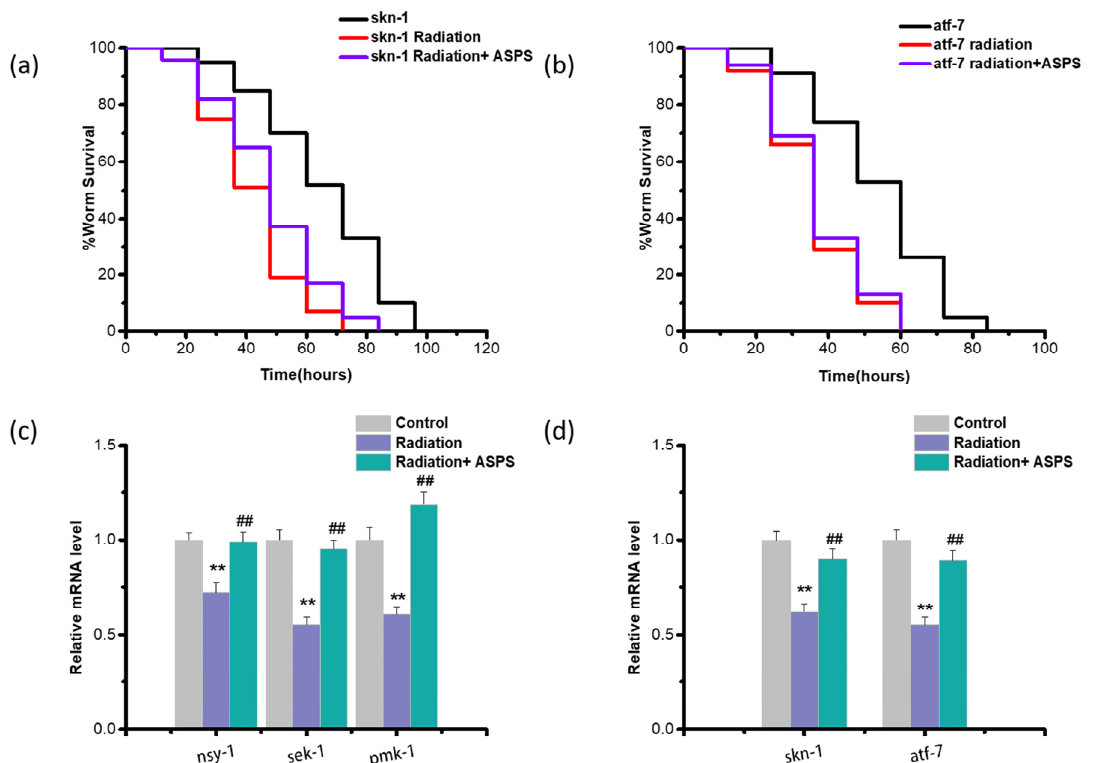
Figure 6. ASPS affected the genes related to p38 MAPK signaling pathway. ( a , b ) Survival curve of PA14-infected skn-1 mutant and atf-7 mutant. ( c , d ) The expression of genes encoding p38 MAPK pathway and pmk-1 targeted genes. n = 3. Significant difference from the control group was designated as ** p < 0.01, and significant difference from the radiation group was designated as ## p < 0.01,